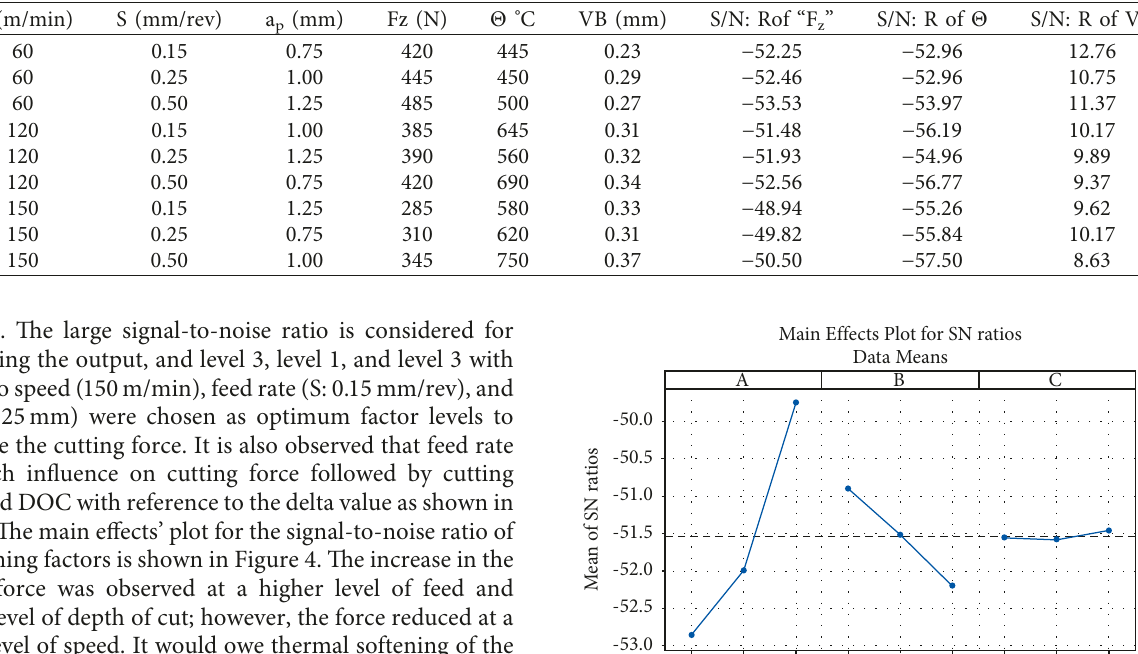
Table 4: Taguchi response table and S/N ratios.